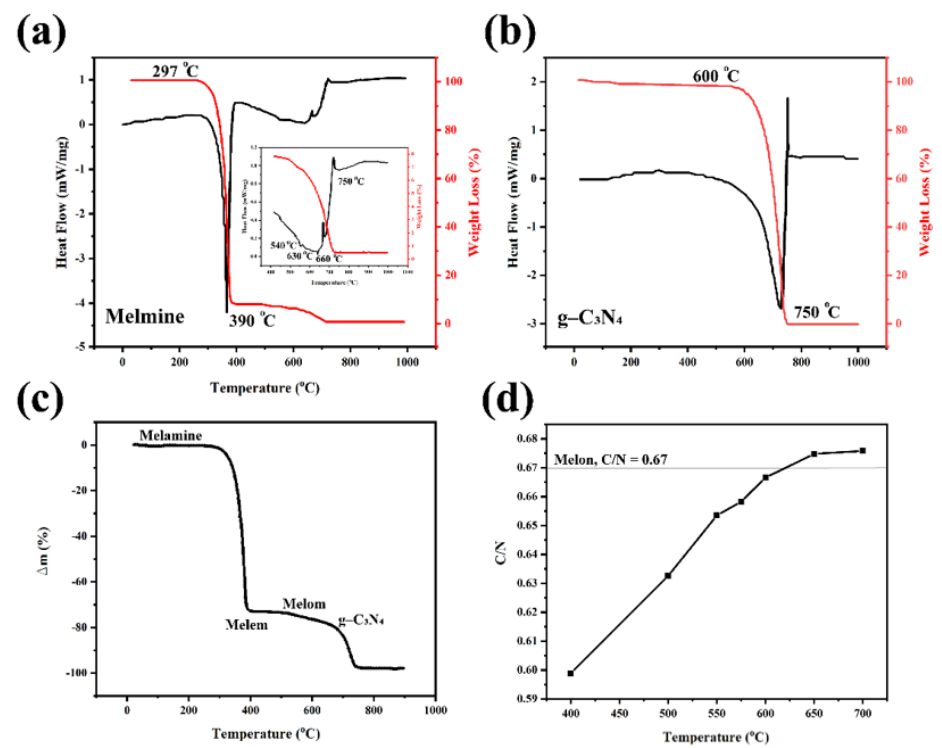
Figure 3. ( a ) Melamine and ( b ) g-C 3 N 4 thermal analyses, Copyright © 2022 American Chemical society [31]; ( c ) thermogravimetric curve of annealing of melamine; ( d ) C/N values of melamine products at different temperatures, Copyright © 2022 Elsevier [32].